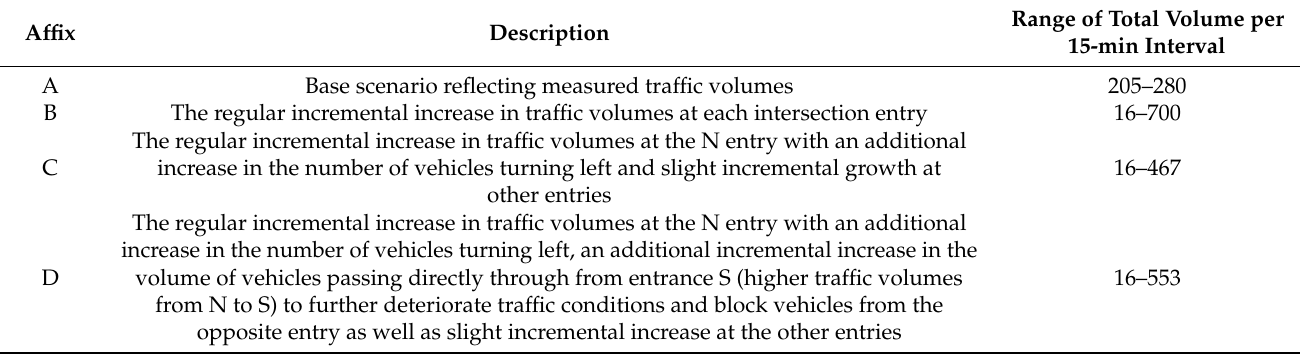
Table 4. Modeled scenarios for traffic volume